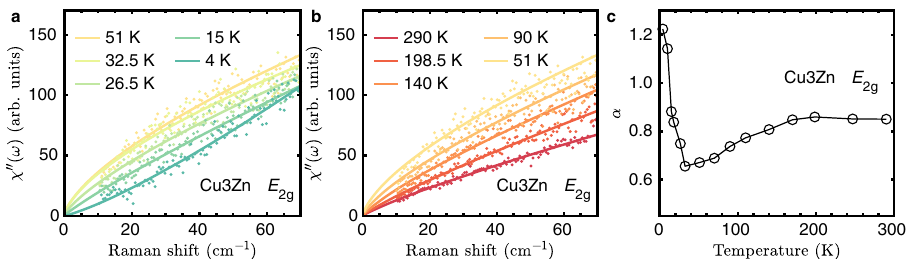
ð ω Þ / ω α at low and high 2g